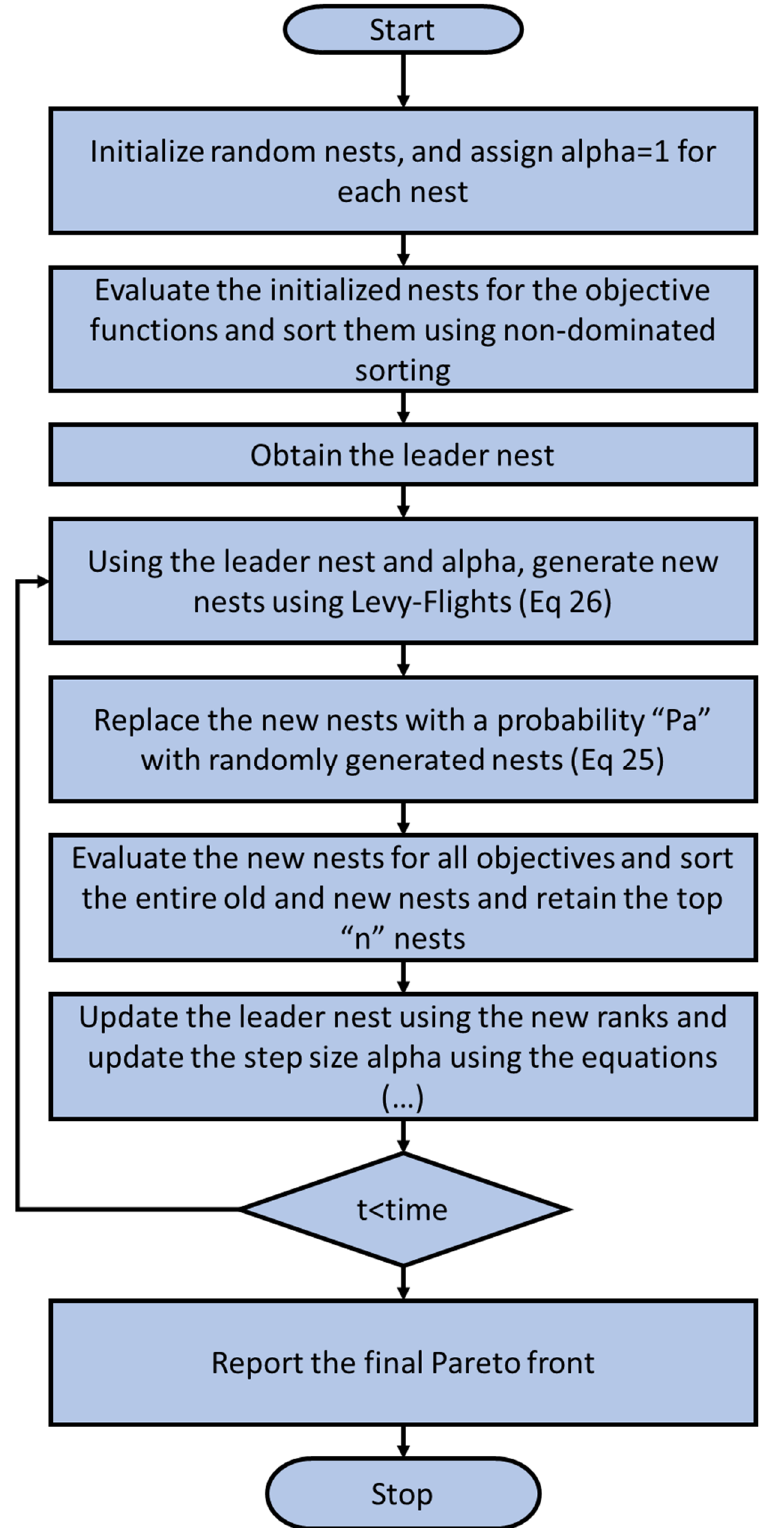
Figure 1. Flow chart of self-adaptive multi-objective Cuckoo search algorithm (SAMOCSA).